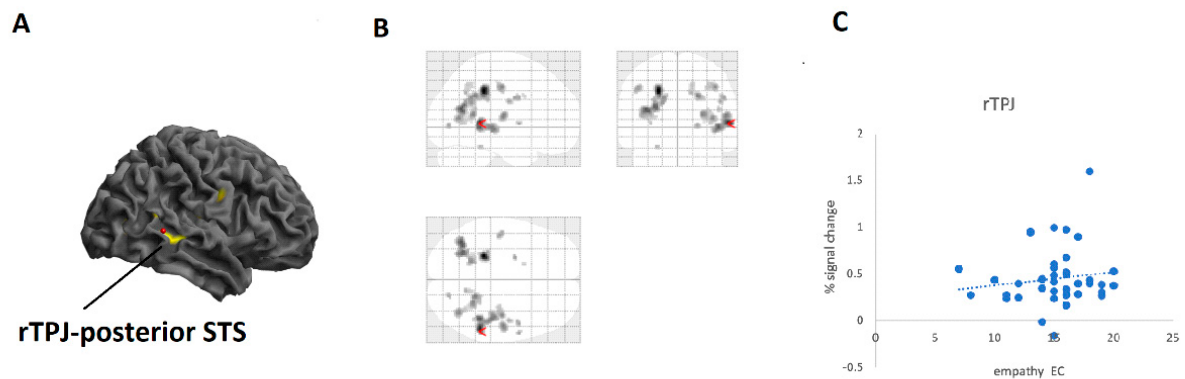
Figure 4. ( A ): Brain responses for trials with social relative to trials with non-social decisions predicted by the empathy subscale empathic concern. Results revealed brain activation in rTPJ-posterior STS (at p < 0.001, uncorrected, for picture display only). ( B ): Glass brain depicting same contrast as in A (at p < 0.001, uncorrected). ( C ): Scatterplot showing empathic concern correlated with peak activation in rTPJ-posterior STS brain region (Pearson’s correlation: r =